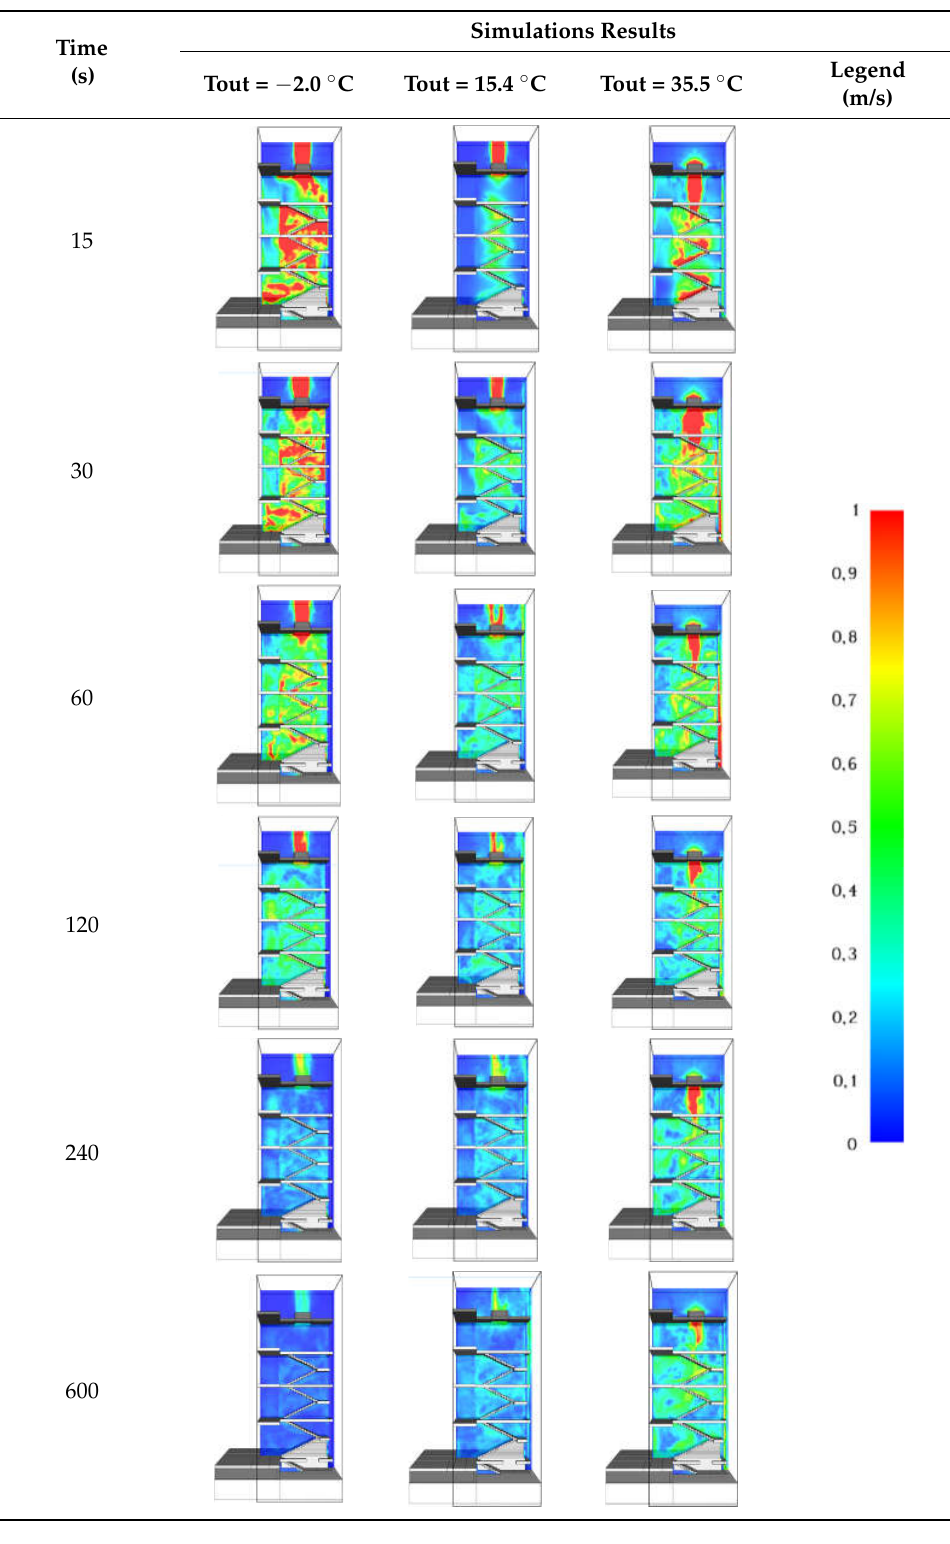
Table 3. Variation in air velocity in the staircase space depending on the outside temperature.